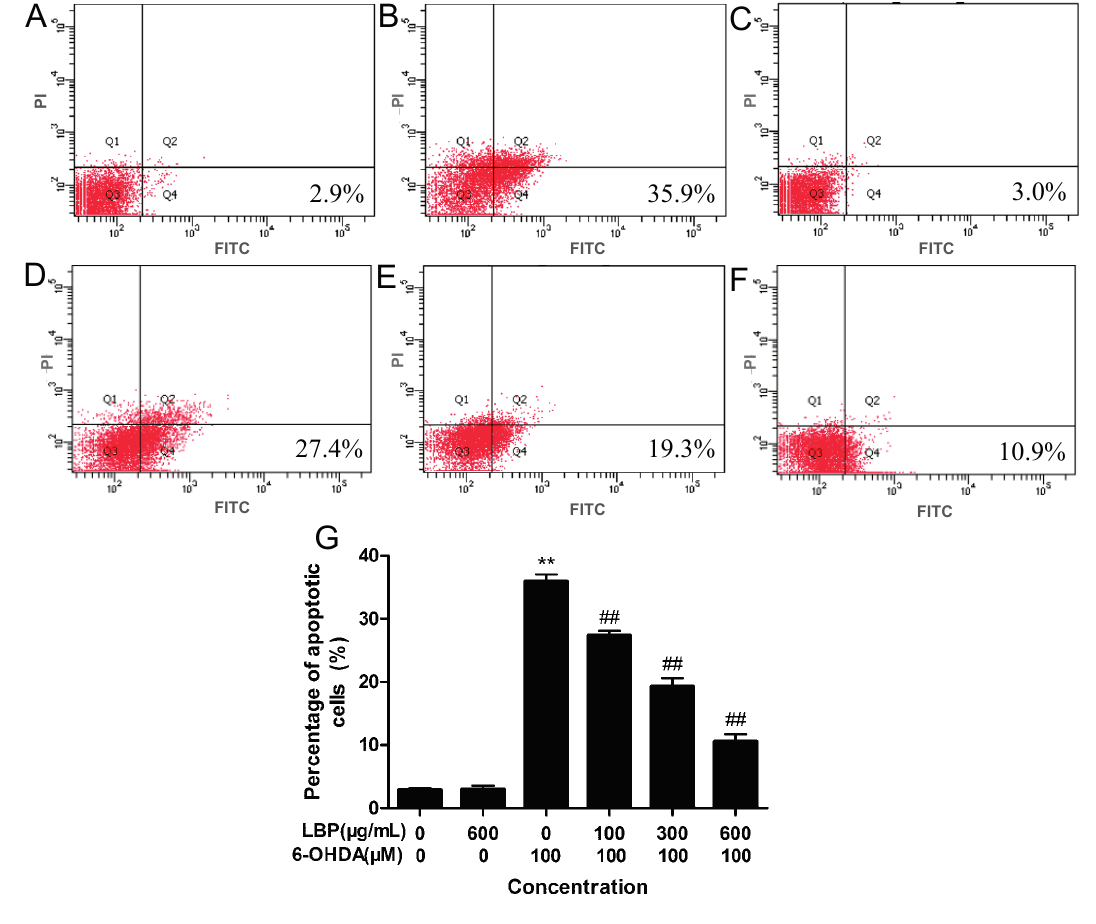
Figure 3. Cell apoptosis was tested by flow cytometry analysis. PC12 cells were incubated in drug-free medium ( A ) or medium containing 600 μ g/mL LBP; ( B ) or 75 μ M 6-OHDA; ( C ) for 24 h, or cells were preincubated with 100 μ g/mL ( D ); 300 μ g/mL ( E ) or 600 μ